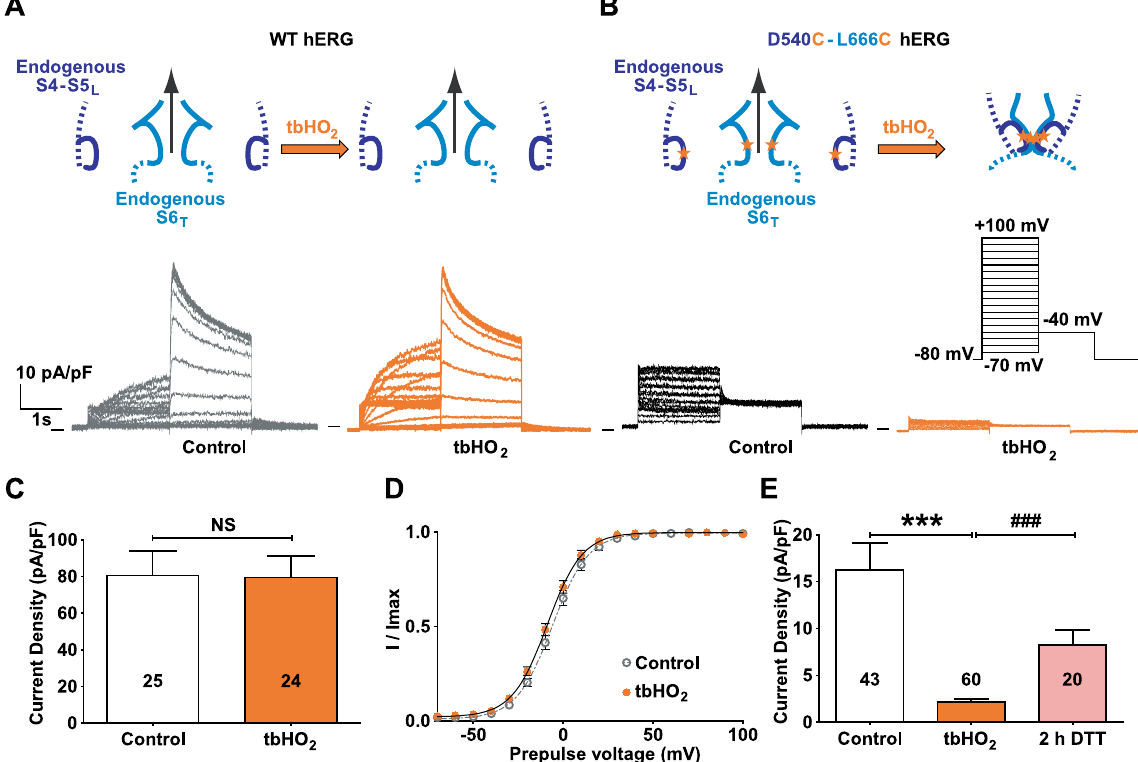
Figure 4. Introduction of 2 cysteines in the S4-S5 L and S6 T regions of hERG (D540C-L666C hERG) locks the channel closed in oxidative conditions. ( A ) Representative, superimposed recordings of the WT hERG current (3.6 µ g plasmid plus 0.4 µ g GFP plasmids) after 2 h incubation in Tyrode without (control) or with 0.2 mM tbHO 2 (tbHO 2 ). ( B ) D540C-L666C hERG channels, same as in A (3.6 µ g plasmid plus 0.4 µ g GFP plasmids). Cartoons: introduction of a cysteine is symbolized by a star. ( C ) Mean WT hERG tail-current density at − 40 mV after a prepulse at + 100 mV. ( D ) Activation curve obtained from the tail currents, using the protocol shown in ( B ). ( E ) Mean D540C-L666C hERG tail-current density at − 40 mV after a prepulse at + 100 mV, after 2 h incubation in Tyrode without (control) or with 0.2 mM tbHO 2 (tbHO 2 ), or after 2 h incubation in 10 mM DTT following tbHO 2 incubation (2 h DTT). *** p < 0.001 versus control and ### p < 0.001 versus tbHO 2 , Mann- Whitney